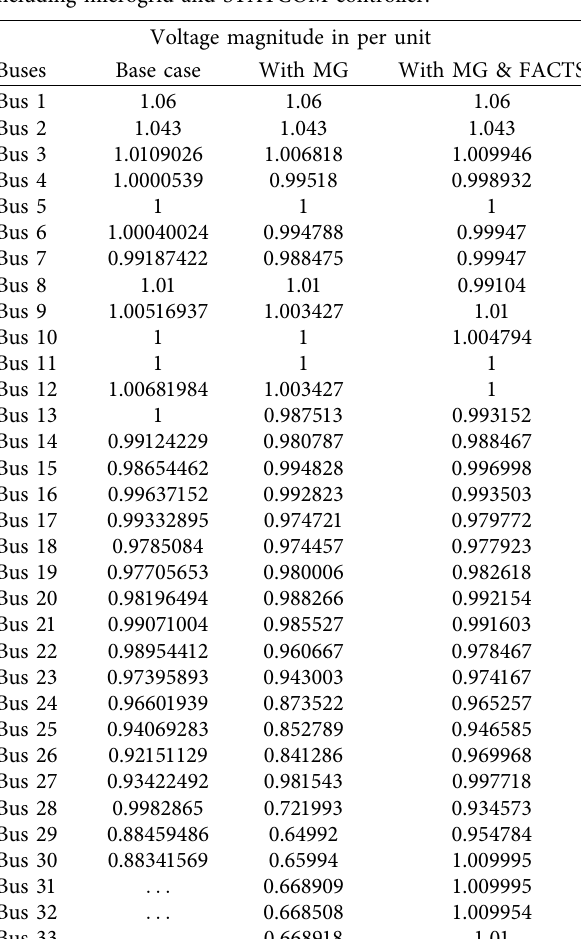
Table 2: Power flow results of voltage in IEEE 30-bus system including microgrid and STATCOM controller.